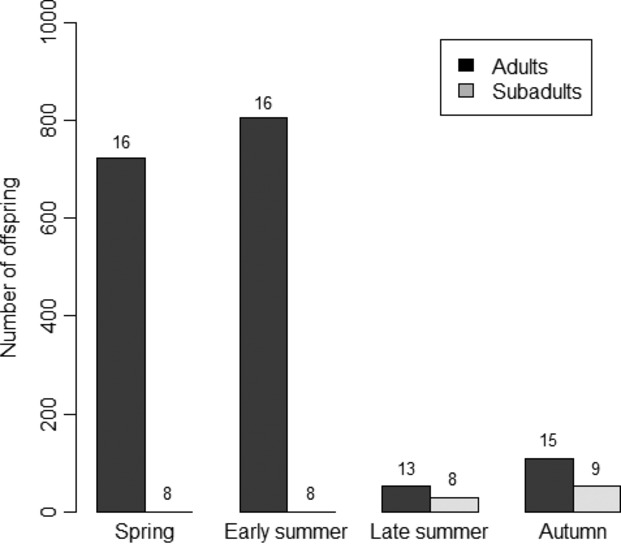
The total number of offspring produced by all mother snails over 30 days in the four seasonal groups. Adult mothers in black, subadult mothers in light gray, and n above bars.